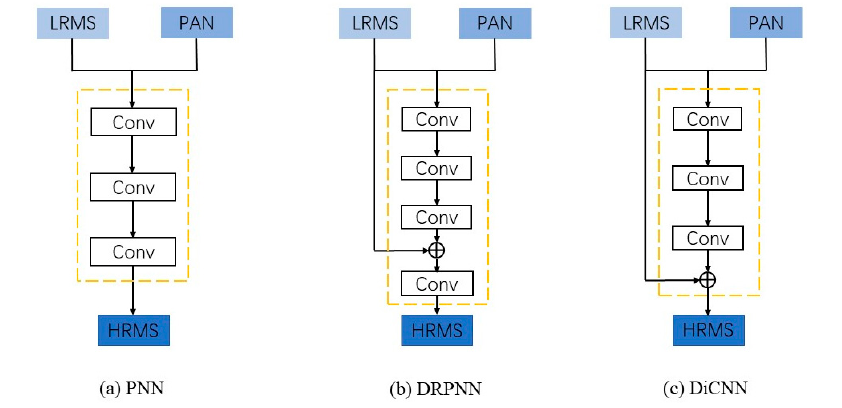
Figure 2. Structures of the CNN-based